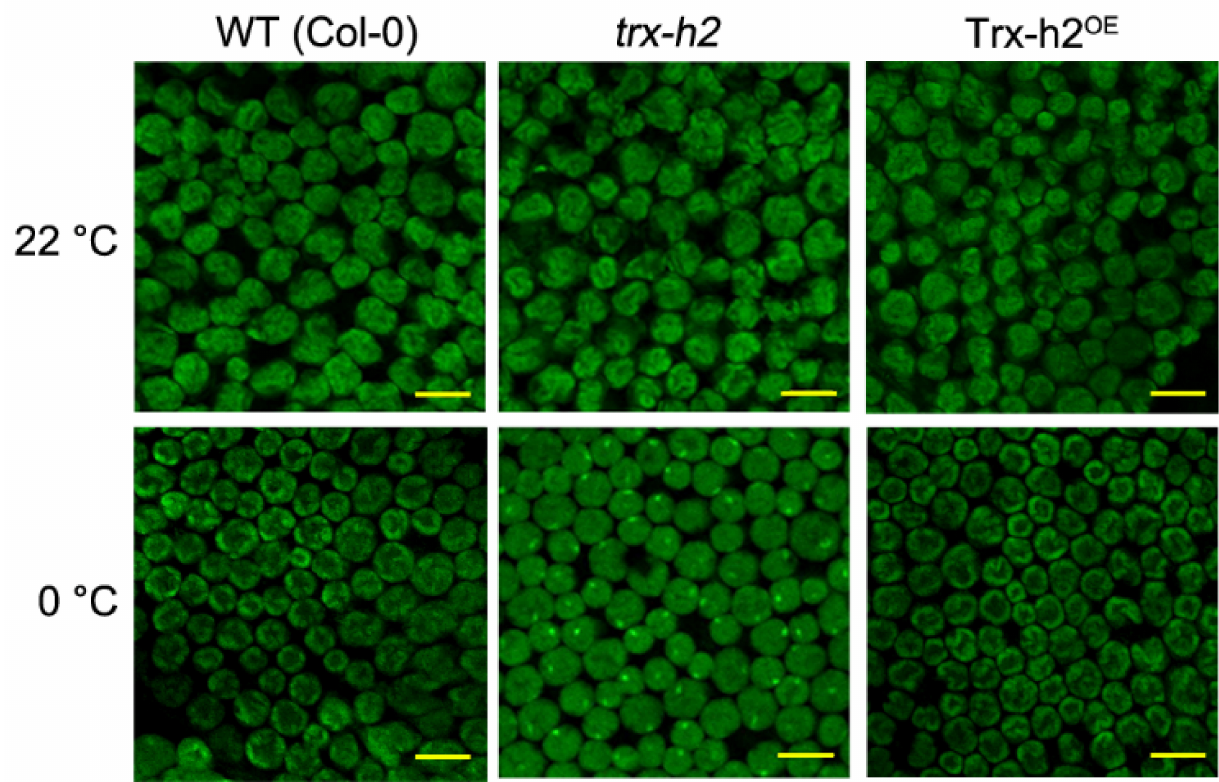
Figure 6. Mutation of Trx-h2 in Arabidopsis disrupts mRNA export from the nucleus to the cytoplasm. The distribution of mRNAs was examined in the leaves of 2-week-old WT (Col-0), trx-h2, and Trx-h2 OE Arabidopsis plants at 22 ◦ C or 0 ◦ C by in situ poly(A) mRNA hybridization. After fixation the leaves, 5 (cid:48) -fluorescein-labeled oligo(dT) probe was hybridized and the fluorescence of the leaf cells was observed using confocal microscopy (Olympus FV500) at excitation and emission wavelengths of 488 and 522 nm, respectively. Scale bars = 20 µ